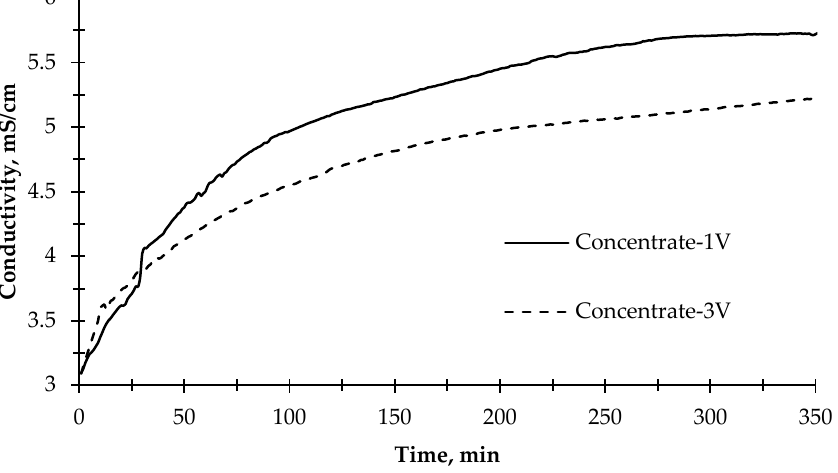
33.544.555.56 Figure 6. The change of electrical conductivity of the concentrate solution during the desalination experiment with 1 V and 3 V applied potentials and illuminated with the sun simulator. Figure 7. The change of pH values of the anode and cathode solutions (BTTWW) during the desalination experiment with 1 V and 3 V applied potentials and illuminated with the sun simulator.